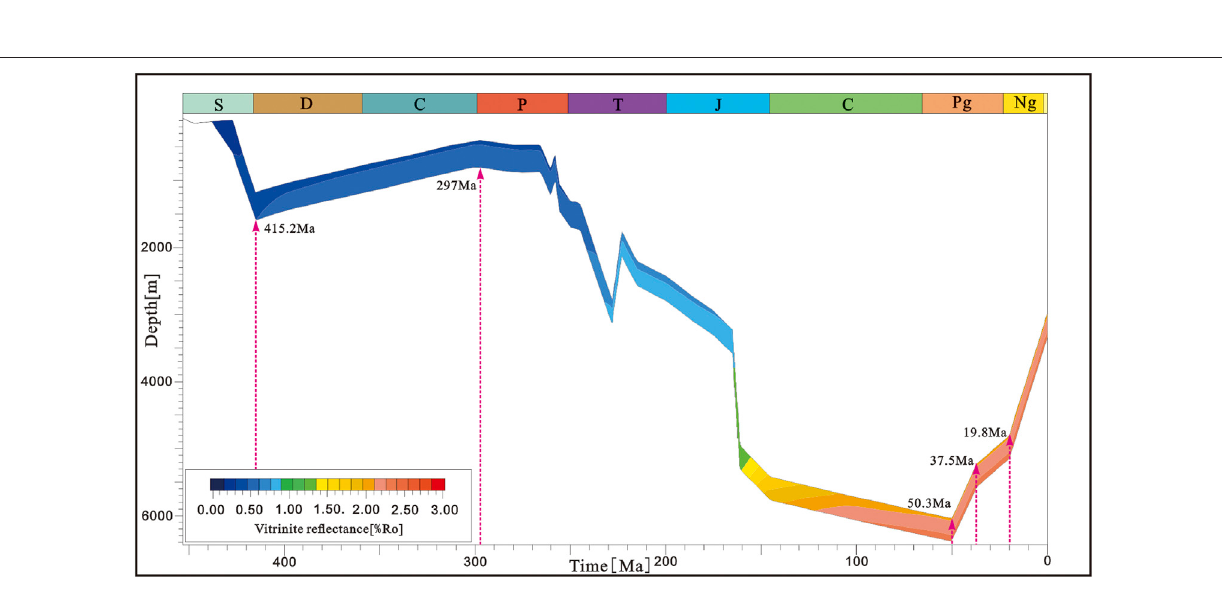
FIGURE 10 | Burial-thermal evolution history of Well